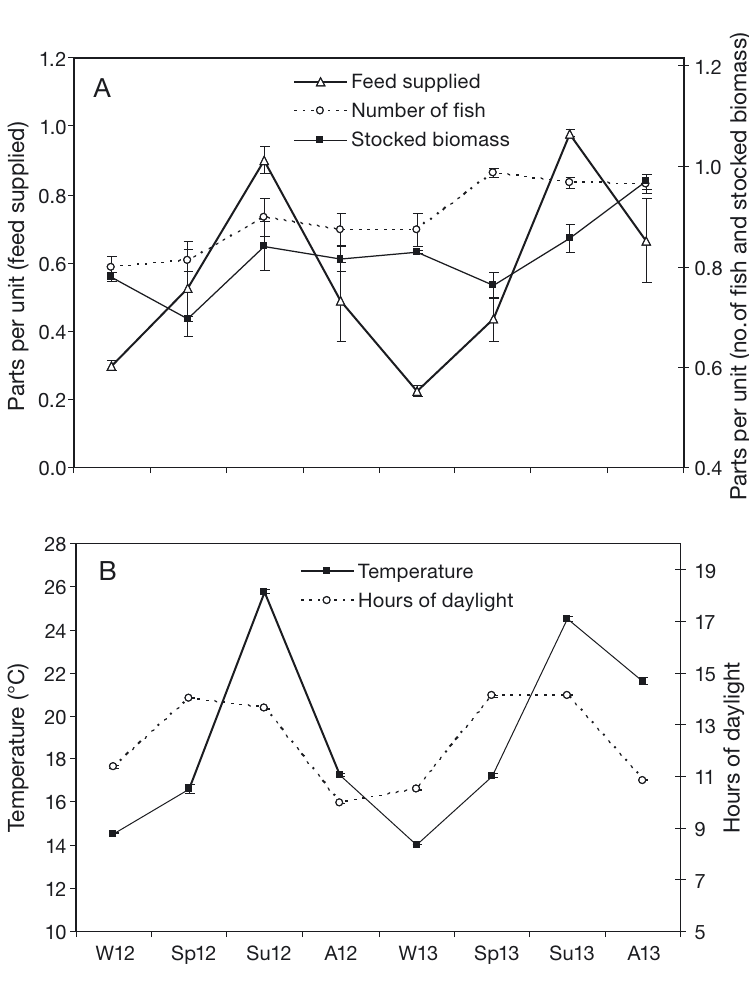
Fig. 5. (A) Average of supplied feed, number of fish and stocked biomass (as parts per unit from the respective reported maximum values) and (B) variation of average temperature and hours of daylight during the study period. W: winter; Sp: spring; Su: summer; A: autumn; 12: 2012; 13: